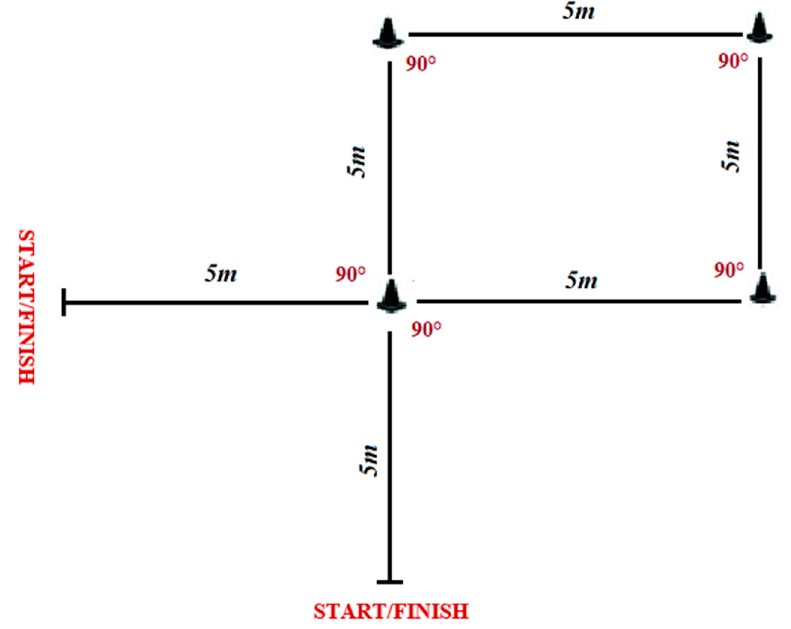
Figure 1. Schematic description of repeated sprint training with change of direction.